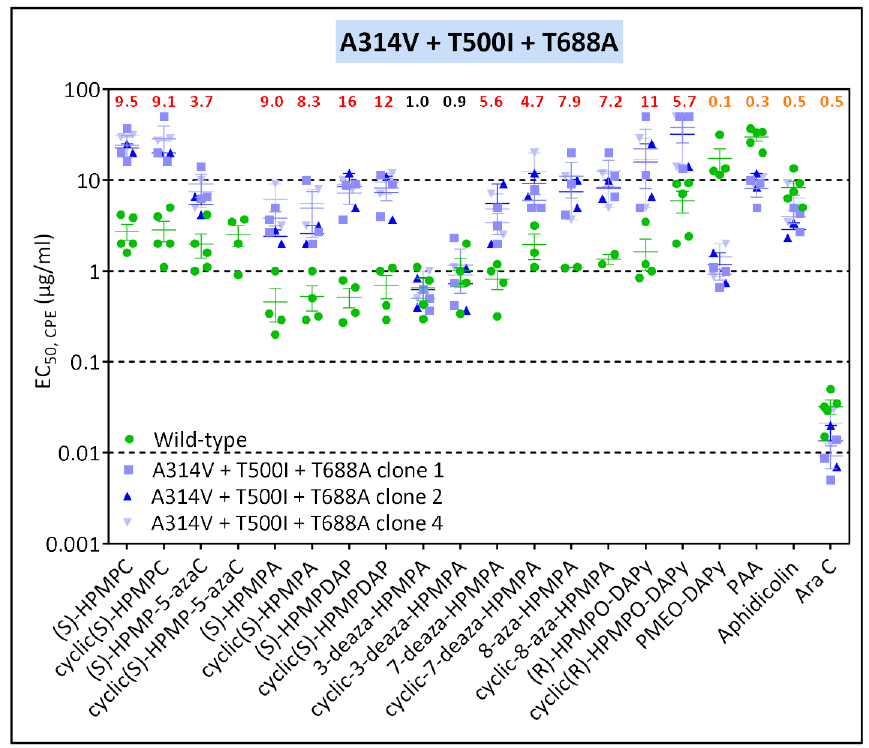
Figure 5. ( A ) Drug-susceptibility profile of selected VV8 viral clones to evaluate the impact of the A314V, L510S, and A684V DNA polymerase substitutions. The source of the viral clones was as follows: A314V + A684V (VV8 HPMPC-R #30) and the A314V + L510S + A684V (VV8 HPMPC-R #37). ( B ) Drug-susceptibility profile of selected viral clones to evaluate the impact of the A314V, T500I, and T688A DNA polymerase substitutions. The source of the viral clones was as follows: A314V (VV8 HPMPC-R #22), A314V + T500I (VV1 HPMPDAP-R #9), and A314V + T500I + T688A (VV1 HPMPDAP-R #37). Drug-resistance properties of the different types of viral clones were determined using a CPE reduction assay with HEL fibroblasts. The effects of different drugs on viruses encoding the indicated mutations were determined by calculating the EC 50 values for the parental wild- type virus and clones bearing the specific mutations. At least two independent experiments were performed for each test compound. Horizontal lines for each drug and mutant viral clones indicate the mean values ± standard deviation. The fold resistance (ratio of the EC50 for the mutant viruses to the EC50 for the corresponding wild-type virus clone is marked at the top of the graph. VACV viral clones showing a ≥ 2-fold increase (red, bold) were considered drug resistant (R) and those with a ≤ 0.5-fold decrease (orange, bold) drug hypersensitive